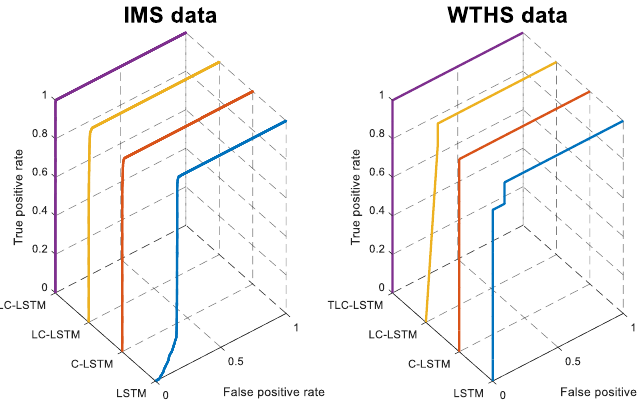
Table 3. Comparison with advanced state of the art methods. RMSE, root mean squared error; IMS, intelligent maintenance systems.